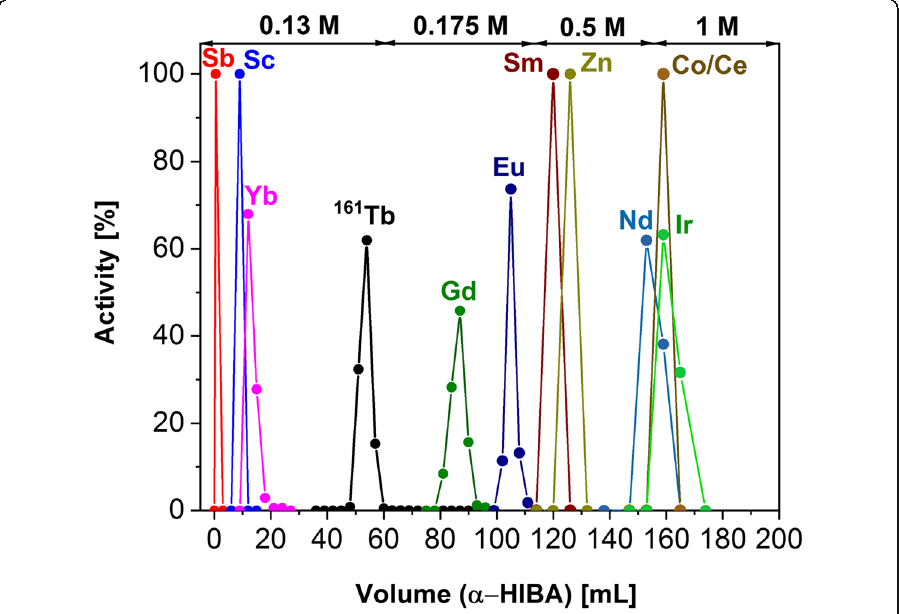
Fig. 1 Elution profile of 161 Tb separation from the irradiated target material and side products (10 mm × 170 mm Sykam resin column, 8 mg 160 Gd 2 O 3 , 0.6 mL/min eluent flow